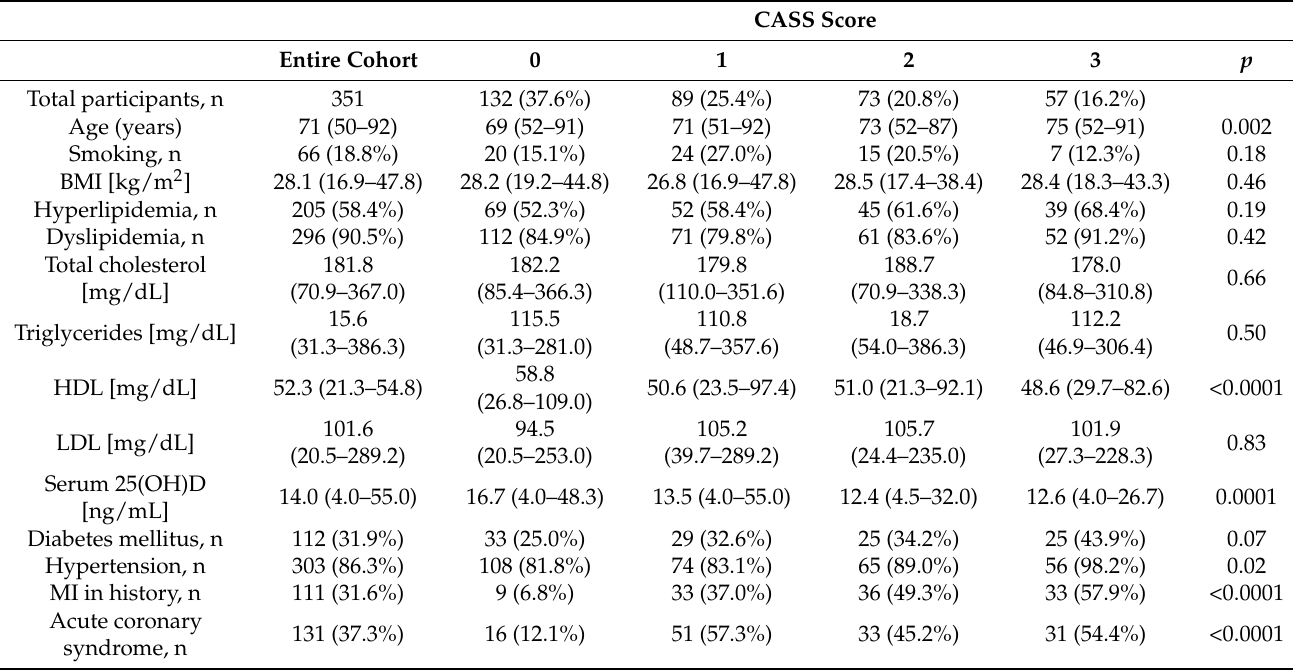
Table 1. Baseline characteristics of the study cohort.